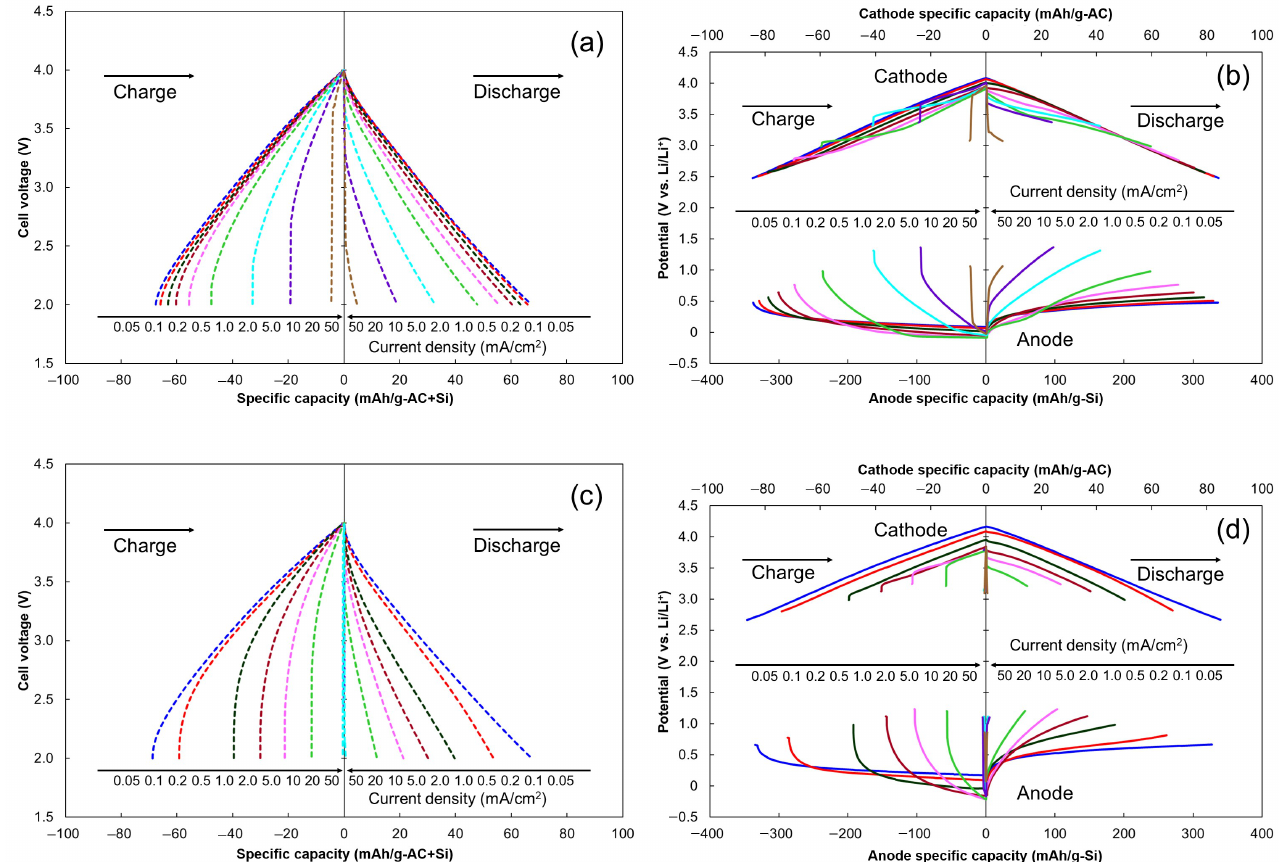
Figure 2. Variations in cell voltages and in cathode and anode potentials of the Si-based LICs during the rate test. ( a ) Cell voltage–specific capacity profile of the 100% prelithiation cell, ( b ) potential variations in the cathode and anode of the 100% prelithiation cell, ( c ) cell voltage–specific capacity profile of the 87% prelithiation cell, and ( d ) potential variations in the cathode and anode of the 87% prelithiation cell.